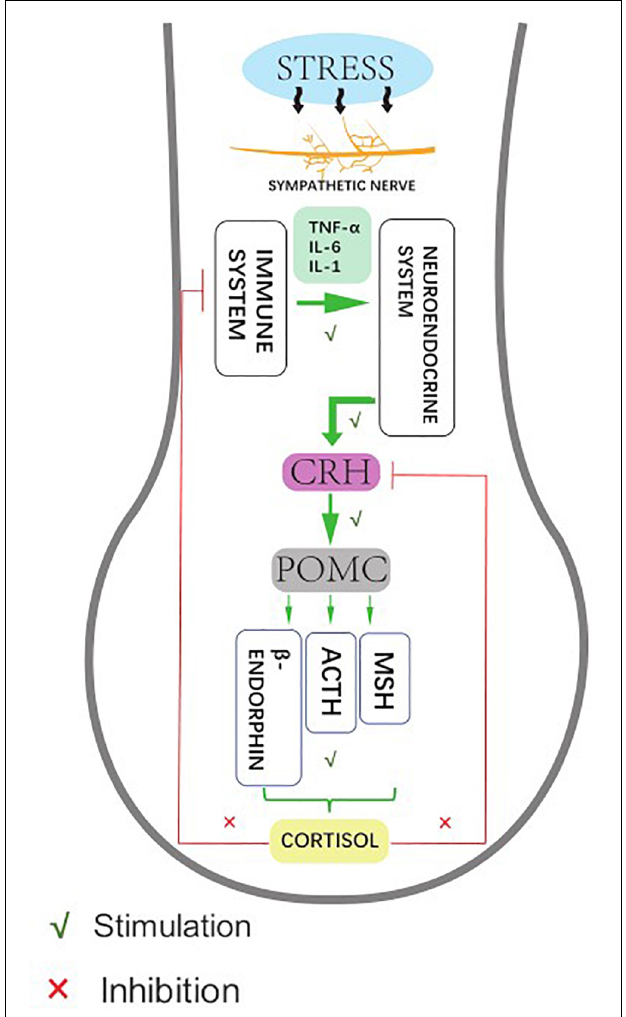
FIGURE 2 | Human hair follicles display HPA axis-like regulatory feedback systems. Affected by hair stress-sensors, the sympathetic nerve activity elevates to different degrees, showing neuroendocrine production and release of corticotropin releasing hormone (CRH), which leads to signal transduction pathway enhances the production and secretion of the anterior pituitary-derived POMC peptides, ACTH, and β -endorphin. Meanwhile, the glucocorticoid receptor agonist cortisol down-regulates follicular CRH expression as an adaptive response to stabilize and restore the general